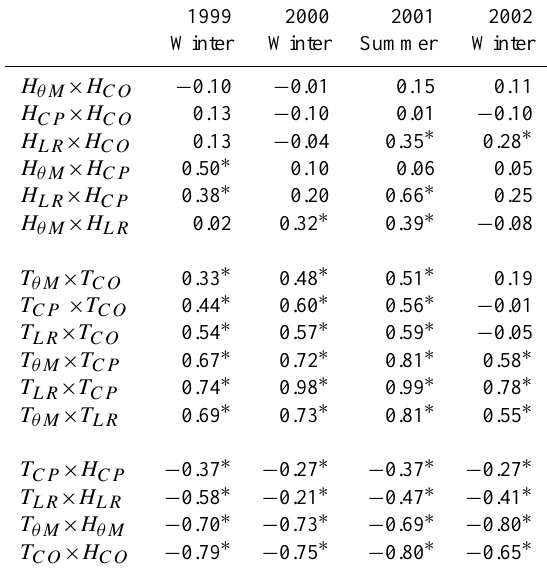
Table 2. The correlation coefficient between the tropopause alti- tudes and temperatures using various